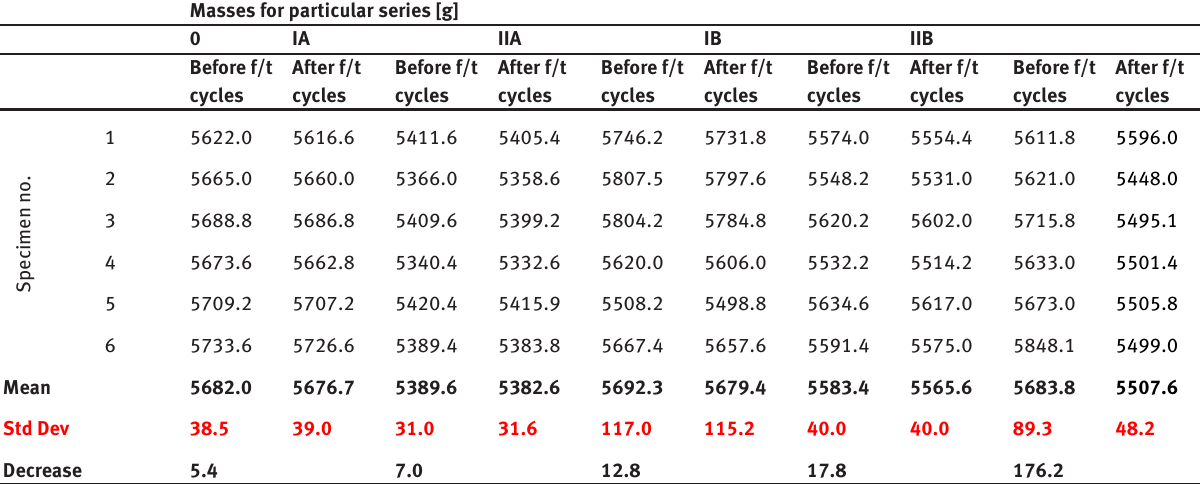
Table 4: Masses of specimens.